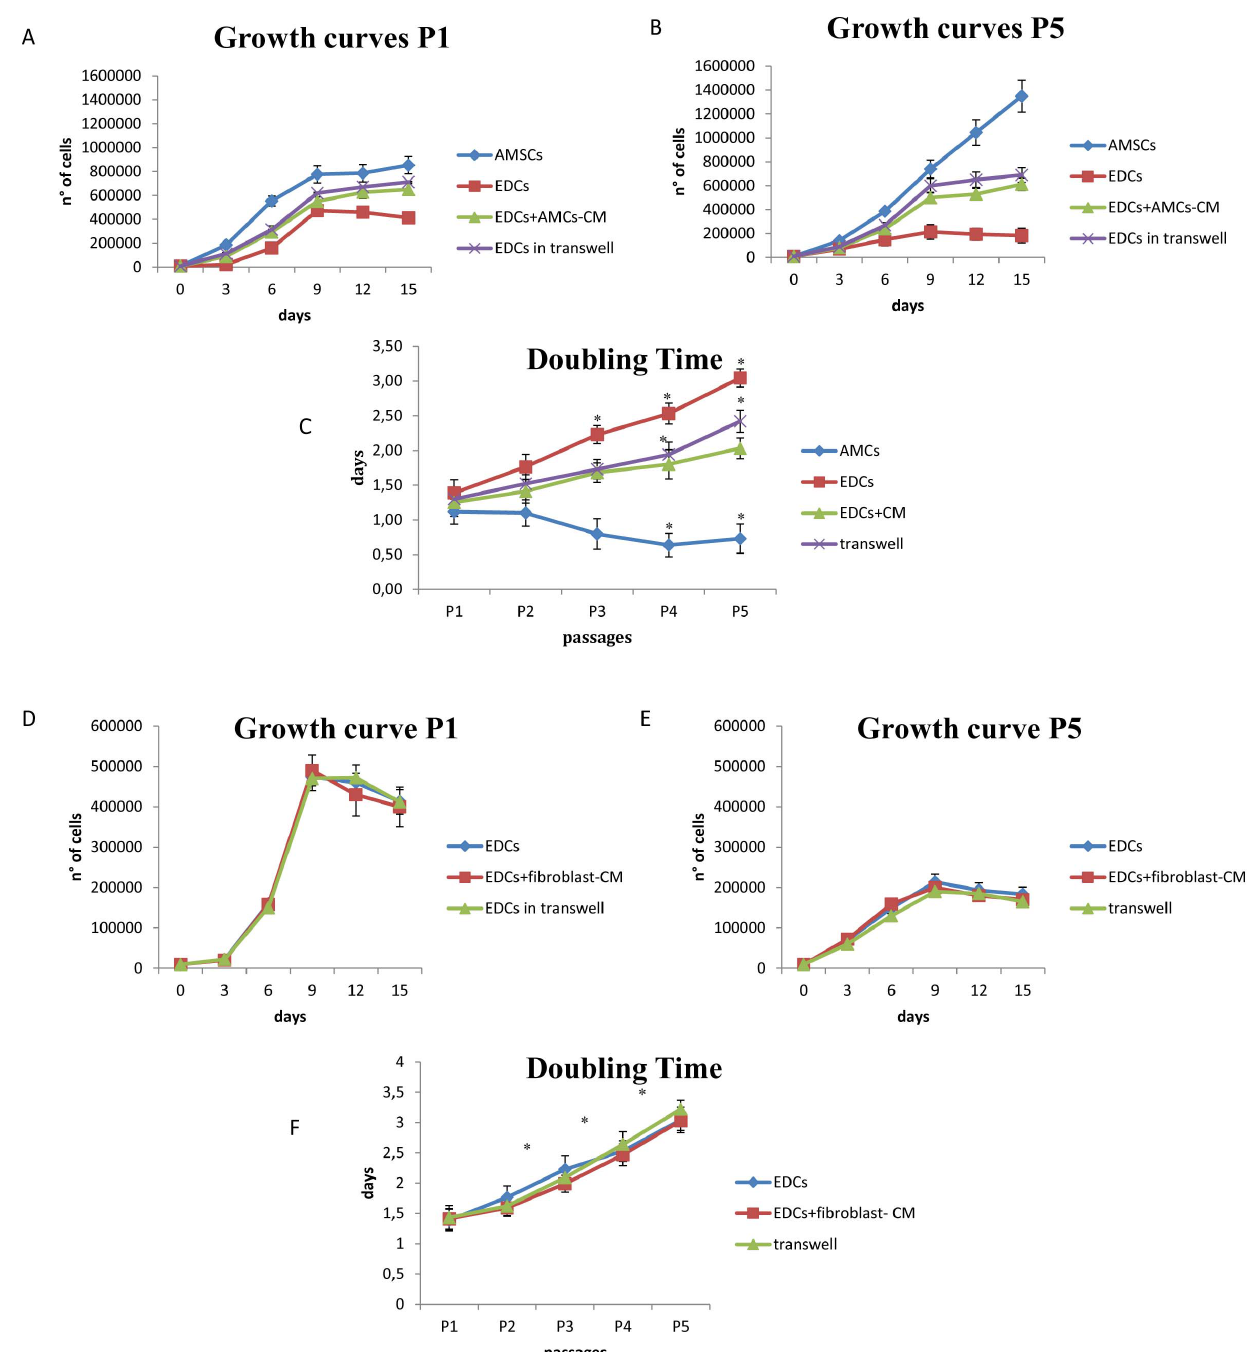
Figure 4. Proliferation studies. Growth curve at P1 (A) and P5 (B) for AMCs and EDCs alone or in co-culture with AMCs by transwell system or by AMC-conditioned medium (AMC-CM). Doubling times at different passages during cell culture for both AMCs and EDCs (C) in different culture conditions. Asterisks represent statistically different doubling times with respect to P1 ( P , 0.01). Growth curve at P1 (D) and P5 (E) for EDCs alone or in co-culture with fibroblast by transwell system or by fibroblast-conditioned medium. Doubling times at different passages during cell culture for EDCs (E) in different culture conditions with fibroblast. Asterisks represent statistically different doubling times with respect to P1 ( P , 0.01).